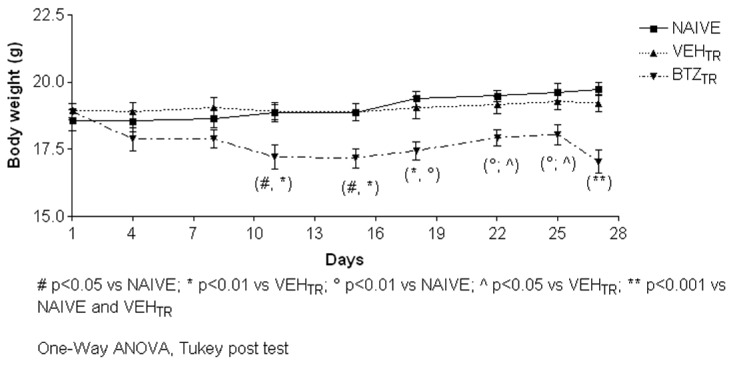
Body weight, experiment 1.Body weights were measured twice a week to monitor bortezomib general toxicity. Ten days after the first injection through the end of the experimental period, bortezomib caused a significant decrease in the body weight of drug-treated mice compared to the naïve and to the vehicle treated ones.